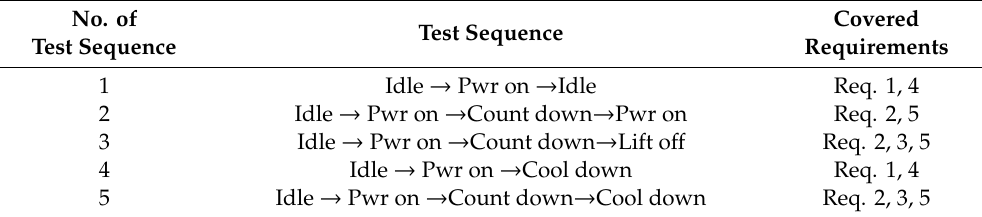
Table 1. Test suite by W